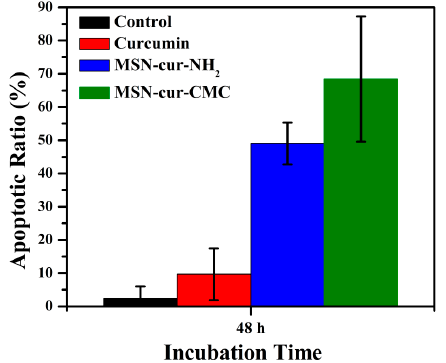
Figure 9. Apoptotic ratios of free curcumin, MSN-cur-NH 2 and MSN-cur-CMC in 48 h.